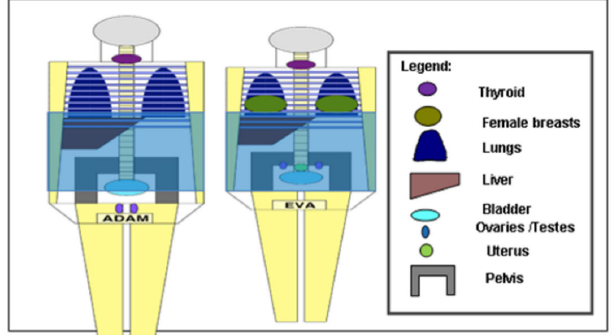
Figure 1. Mathematical phantom for Adam and Eva in Monte Carlo CT ‐ Expo software.